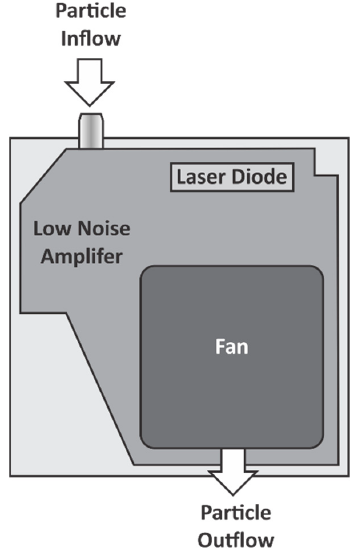
Figure 2. Layout of the SDS011 sensor for measuring particulate matter concentrations.